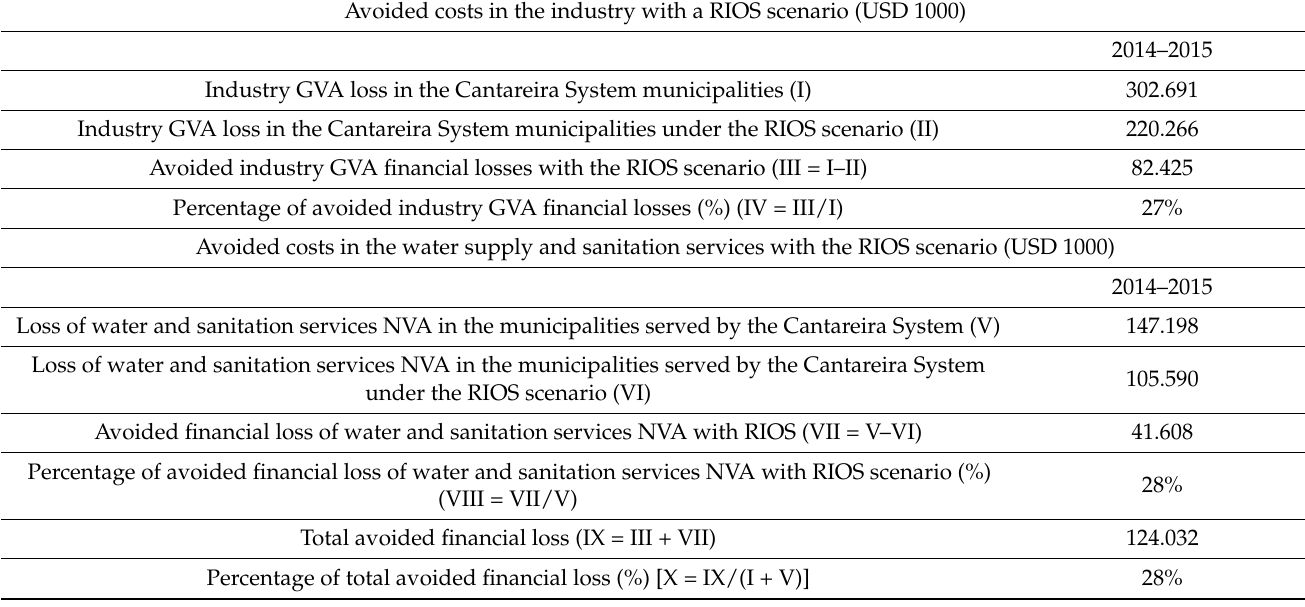
Table 2. Summary of the mitigated financial losses in the industry gross value added (GVA) and the revenues in the supply sector under the RIOS